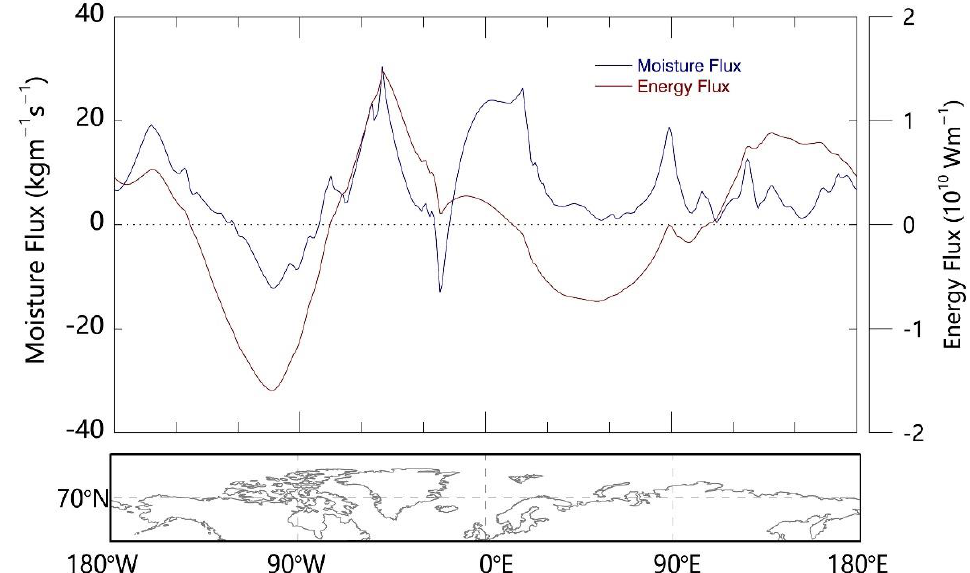
Figure 1. Longitudinal distributions of the climatological vertically integrated total meridional energy and moisture fluxes across 70 ◦ N during 1979–2020. Note that a positive value of meridional moisture flux indicates northward transport, while a negative value is southward.